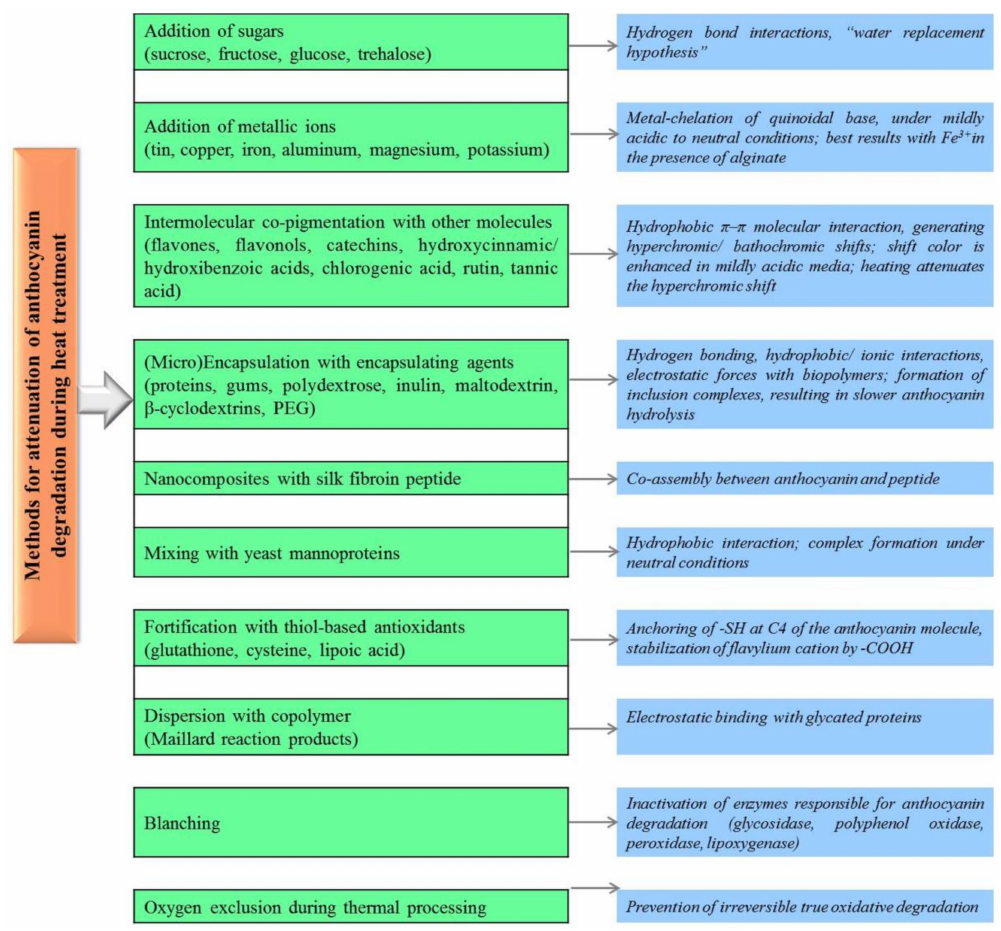
Figure 3. Schematic representation of useful methods for attenuation of the heat induced anthocyanin degradation and their proposed